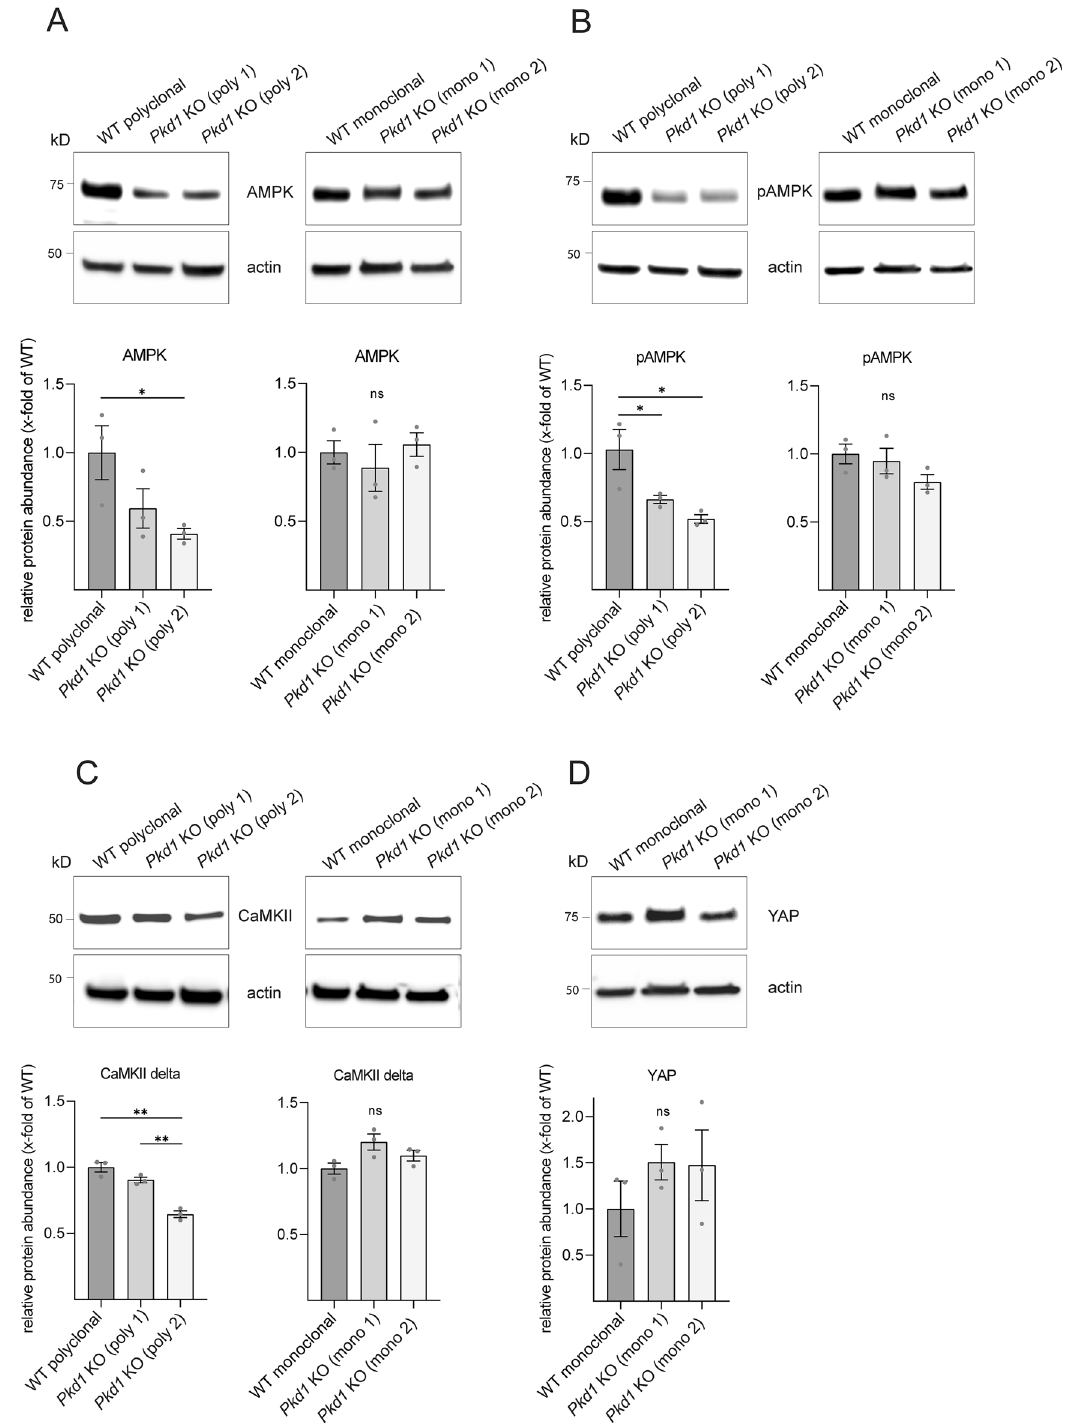
Figure 3. Variability of protein levels for AMPK, pAMPK, CaMKII delta and YAP is reduced in monoclonal compared to polyclonal Pkd1 knockout clones ( A ) Protein abundance of AMPK is significantly reduced in Pkd1 KO clone 2 compared to polyclonal WT control. Monoclonal Pkd1 KO clones show no significant differences in protein abundance of AMPK compared to monoclonal WT control. ( B ) Protein abundance of pAMPK is significantly reduced in both polyclonal Pkd1 KO clones compared to polyclonal WT control. Monoclonal Pkd1 KO clones show no significant differences compared to isogenic WT control. ( C ) Protein abundance of CaMKII delta is significantly reduced in Pkd1 KO clone 2 compared to polyclonal WT control and Pkd1 KO clone 1. Monoclonal Pkd1 KO clones show no significant differences compared to isogenic WT control. ( D ) Monoclonal Pkd1 KO clones show no significant differences in protein abundance of YAP compared to isogenic WT control. Polyclonal setting is illustrated in Fig. 1. Three independent experiments were included in each analysis of protein levels. Error bars represent SEM. Statistical significance was evaluated using unpaired t-test. *Indicates p < 0.05. **Indicates p < 0.01. ***Indicates p < 0.001. ns means non-significant. Unprocessed blots for ( A – D ) are presented in Supplementary Figs. S8, S9, S10, and